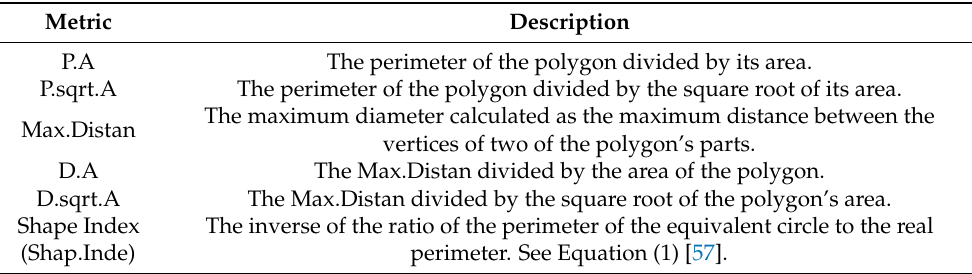
Table 3. Set of metrics calculated on the polygon formed by each disturbance cluster. The polygon was obtained from the concave hull of the disturbance pixel